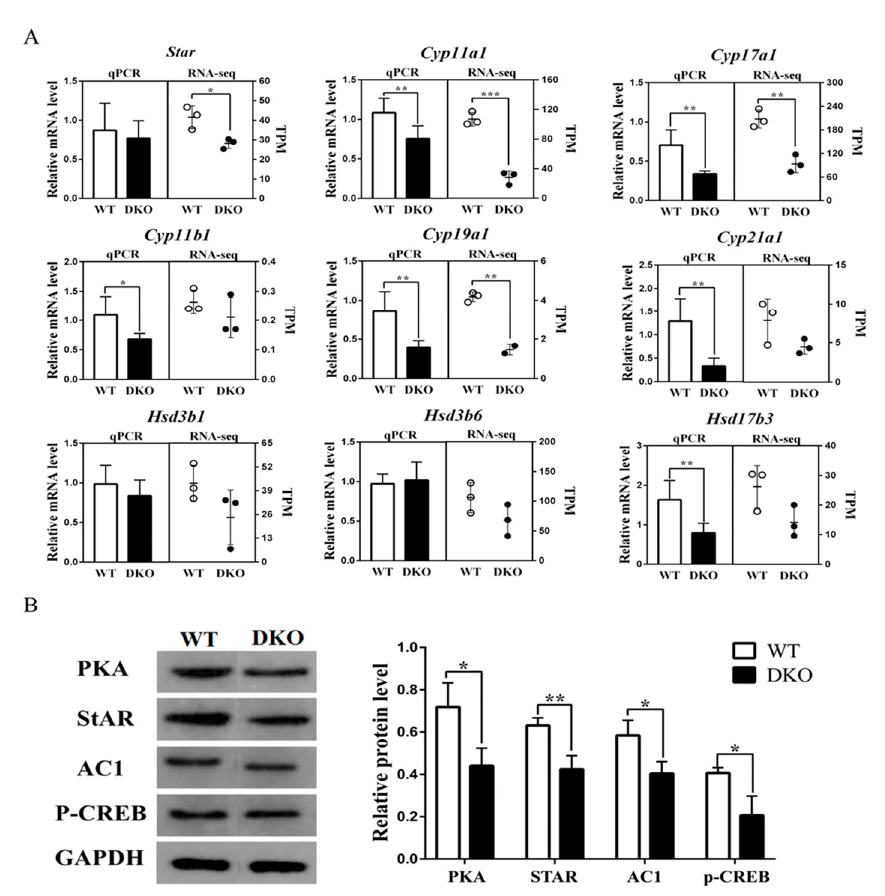
Figure 4. Expression of genes and signaling pathways associated with testicular steroid biosynthesis. ( A ) RT-qPCR results (left side of each image, n = 10) and mRNA relative expression in TPM (right side of each image, n = 3). ( B ) Protein expression of PKA-StAR pathway-related molecules was detected by Western blotting ( n = 3). * p < 0.05; ** p < 0.01.